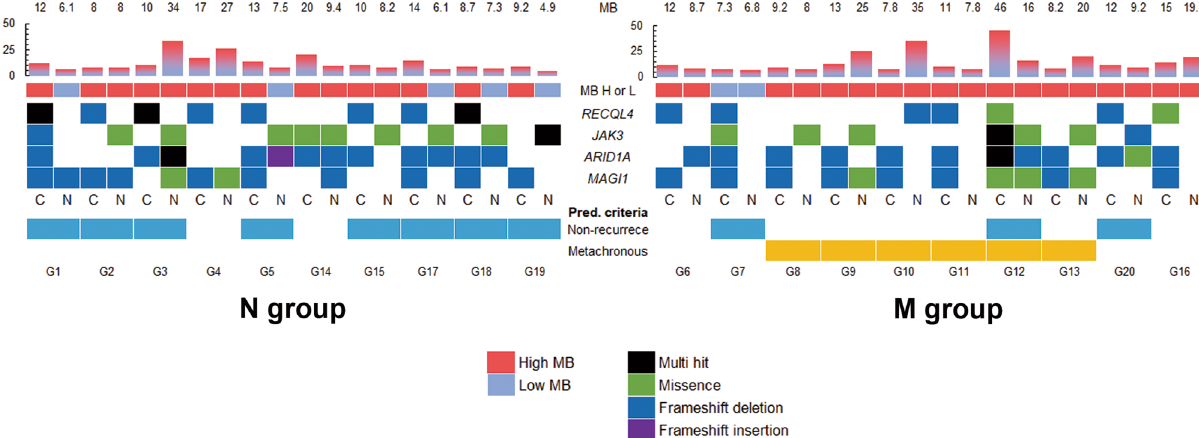
Figure 6. Prediction of metachronous development or non-development based on MB and specific gene variants. MB, mutational burden; H, high; L, low; RECQL4 , RecQ like helicase 4 ; JAK3 , Janus kinase 3 ; ARID1A , AT-rich interactive domain containing protein 1A ; MAGI1 , membrane associated guanylate kinase WW and PDZ domain containing 1 ; N, adjacent non-cancerous lesion; C, initial EGC; Pred. criteria, predictive criteria. The patients met the predictive criteria of non-development as blue whereas metachronous development as orange.